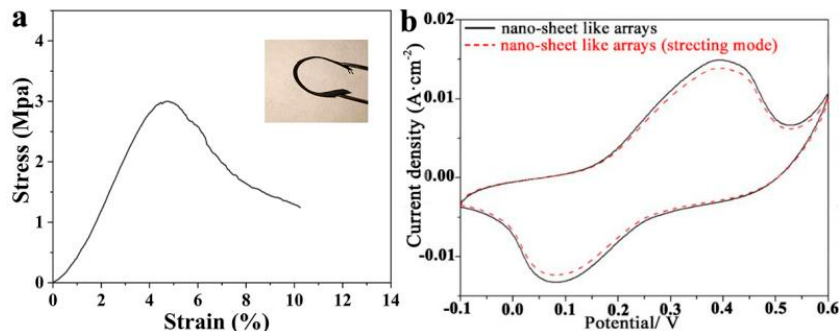
Figure 7. ( a ) Nyquist plots of MHP/ACF electrodes; ( b ) Cycling properties of MHP/ACF electrodes (current density: 10 mA . cm − 2 ).